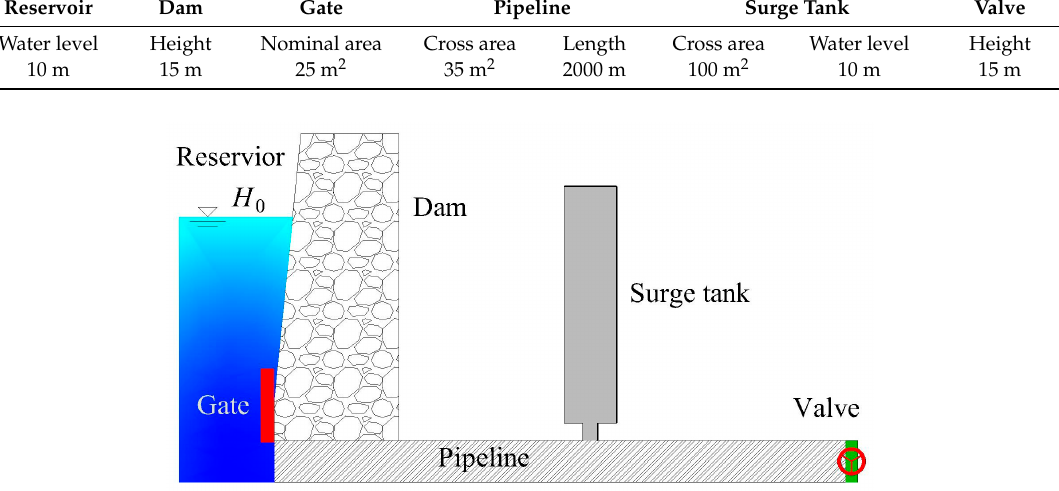
Table 1. Parameters of the pipeline system.